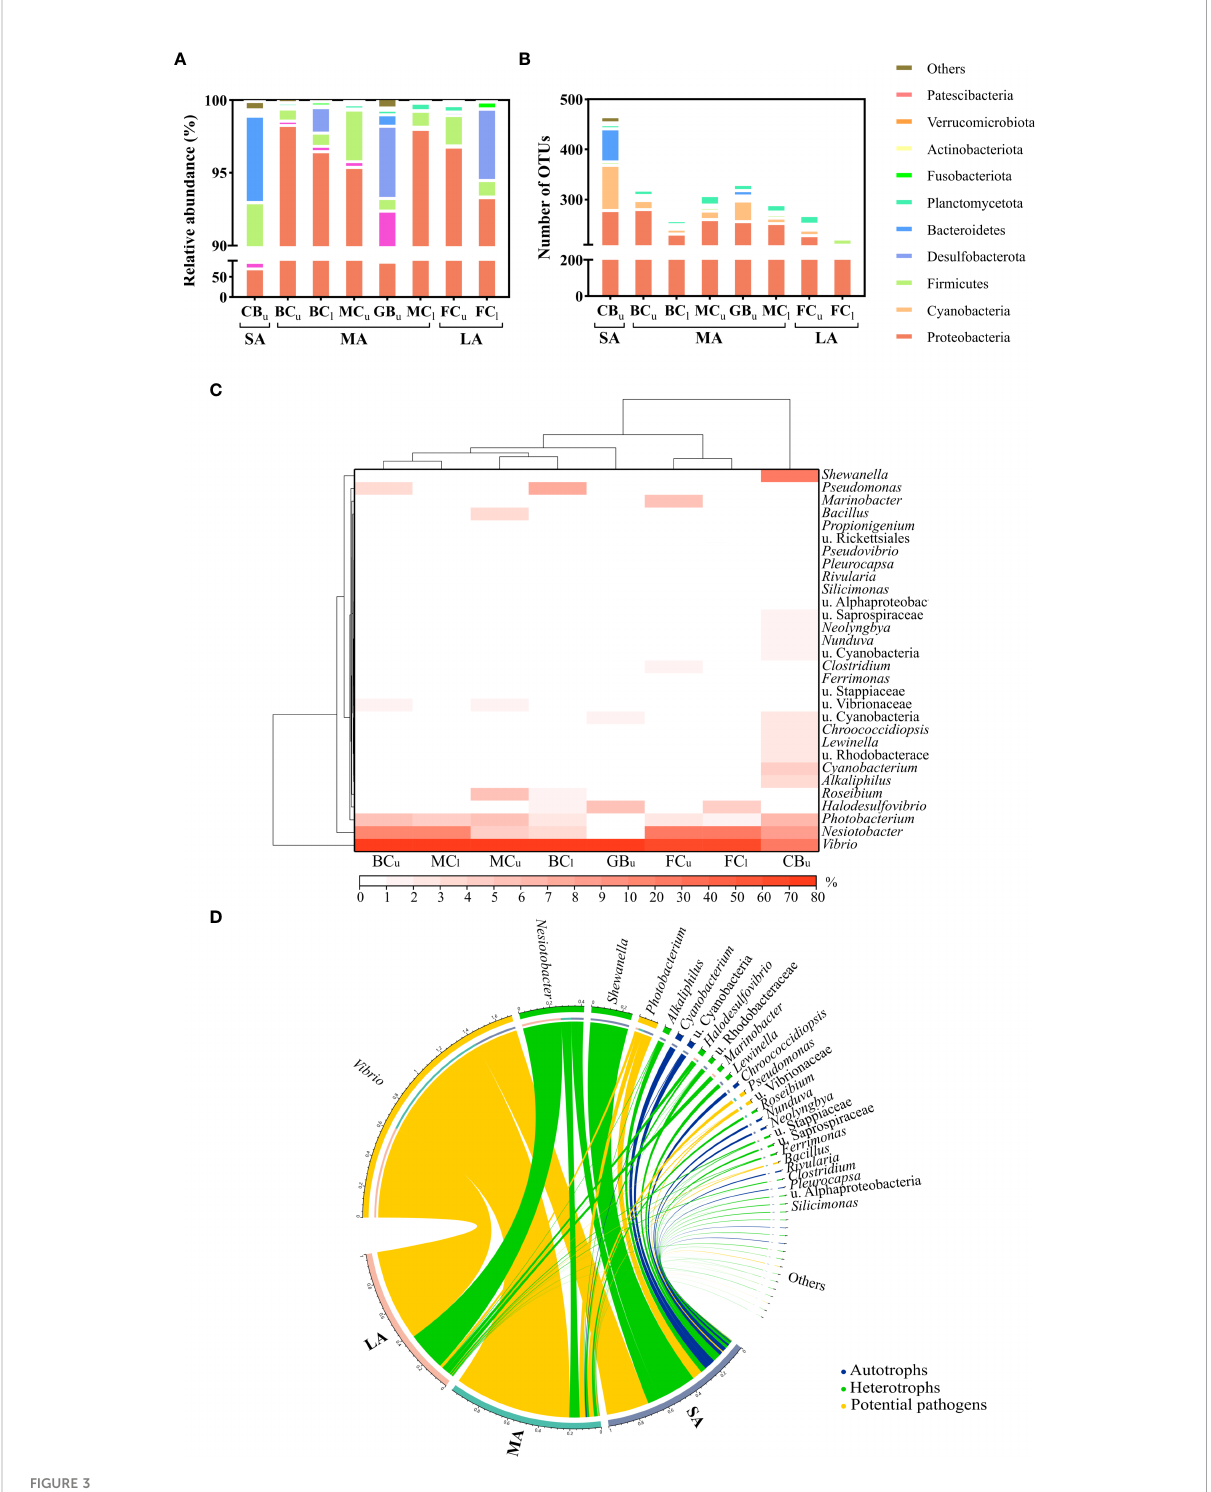
FIGURE 3 Composition of the microbiota of different EAM samples. (A) Relative abundance of the phyla; (B) number of OTUs per phylum; (C) cluster heat maps of the top 30 most abundant bacterial genera; (D) distribution of the microbiota functional categories (The different substrates were divided into three categories: short EAM [SA], medium EAM [MA], and long EAM [LA]. Subscripts indicate different tidal levels, with u and l representing the upper and lower intertidal zones respectively. u.: unclassi fi